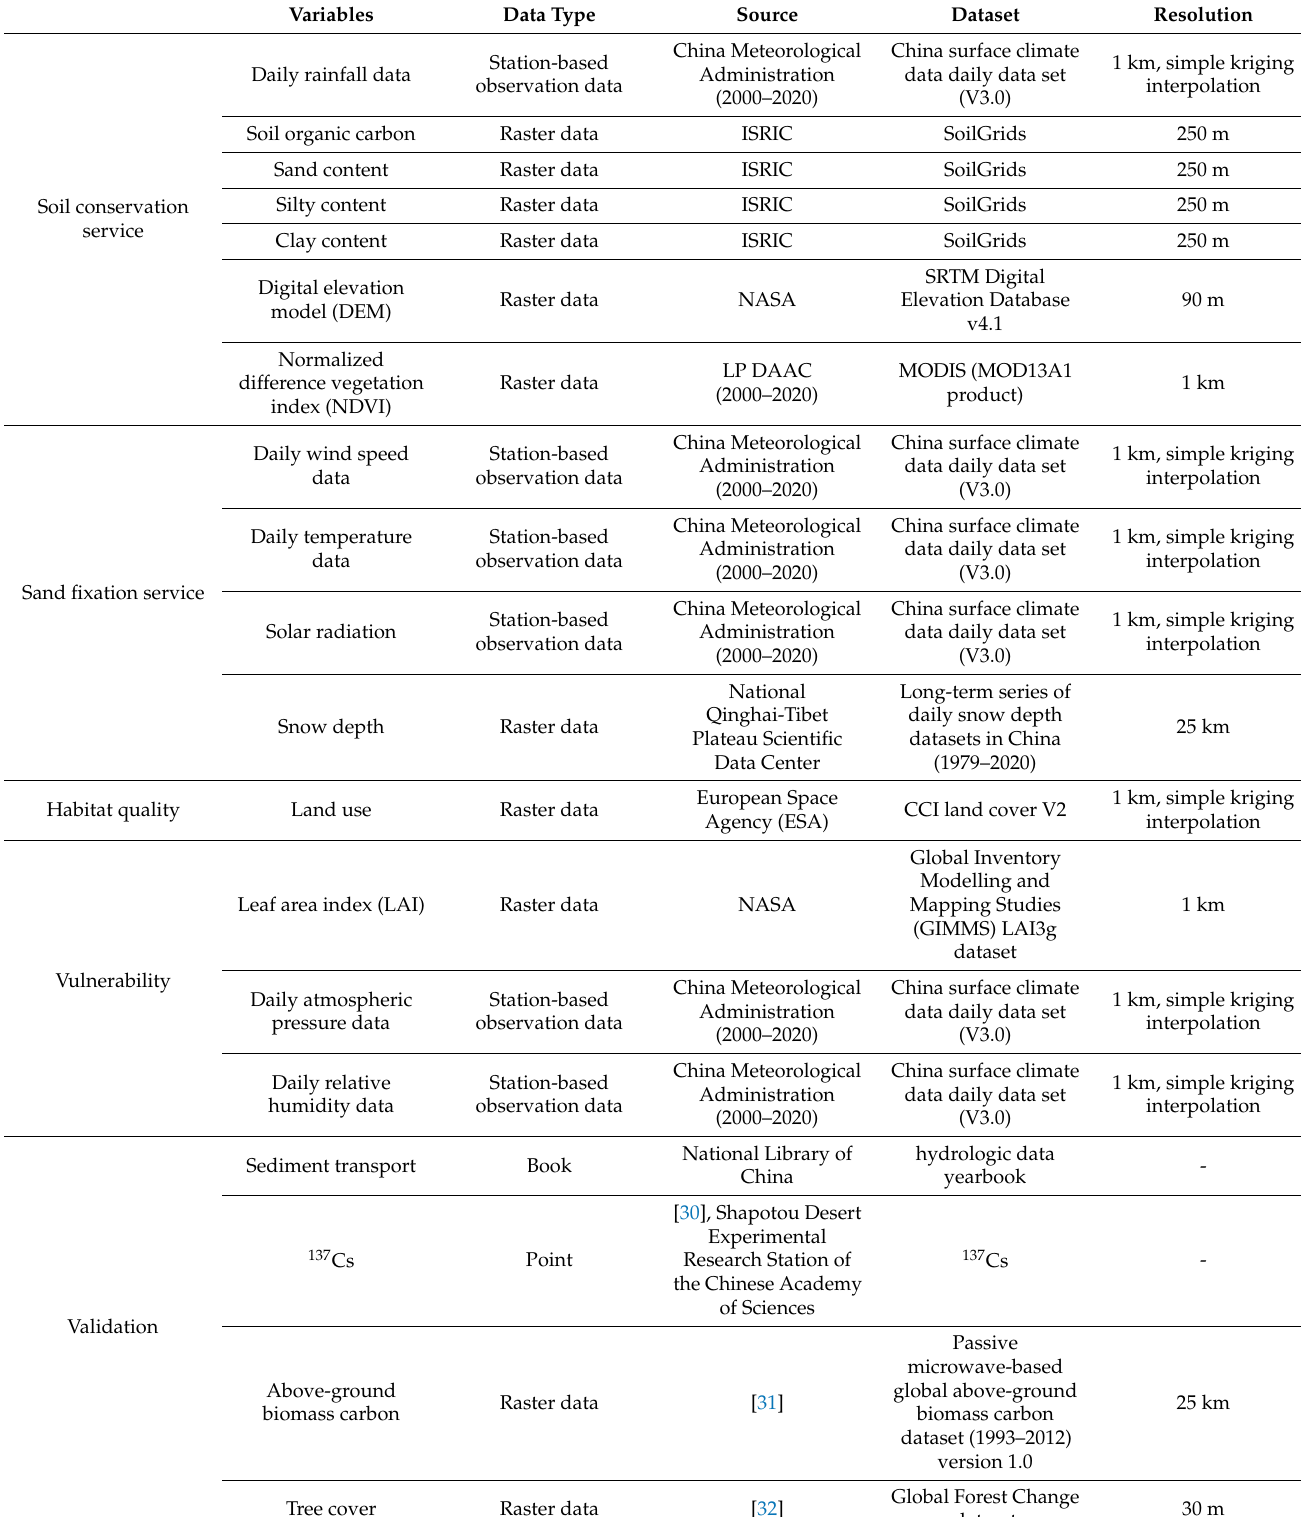
Table 1. Data list, types, sources, datasets, and original resolution. International Soil Reference and Information Centre (ISRIC); National Aeronautics and Space Administration (NASA); Cesium (Cs); Land Processes Distributed Active Archive Center (LP DAAC); Shuttle Radar Topography Mission (SRTM); Moderate-Resolution Imaging Spectroradiometer (MODIS); Climate Change Initiative